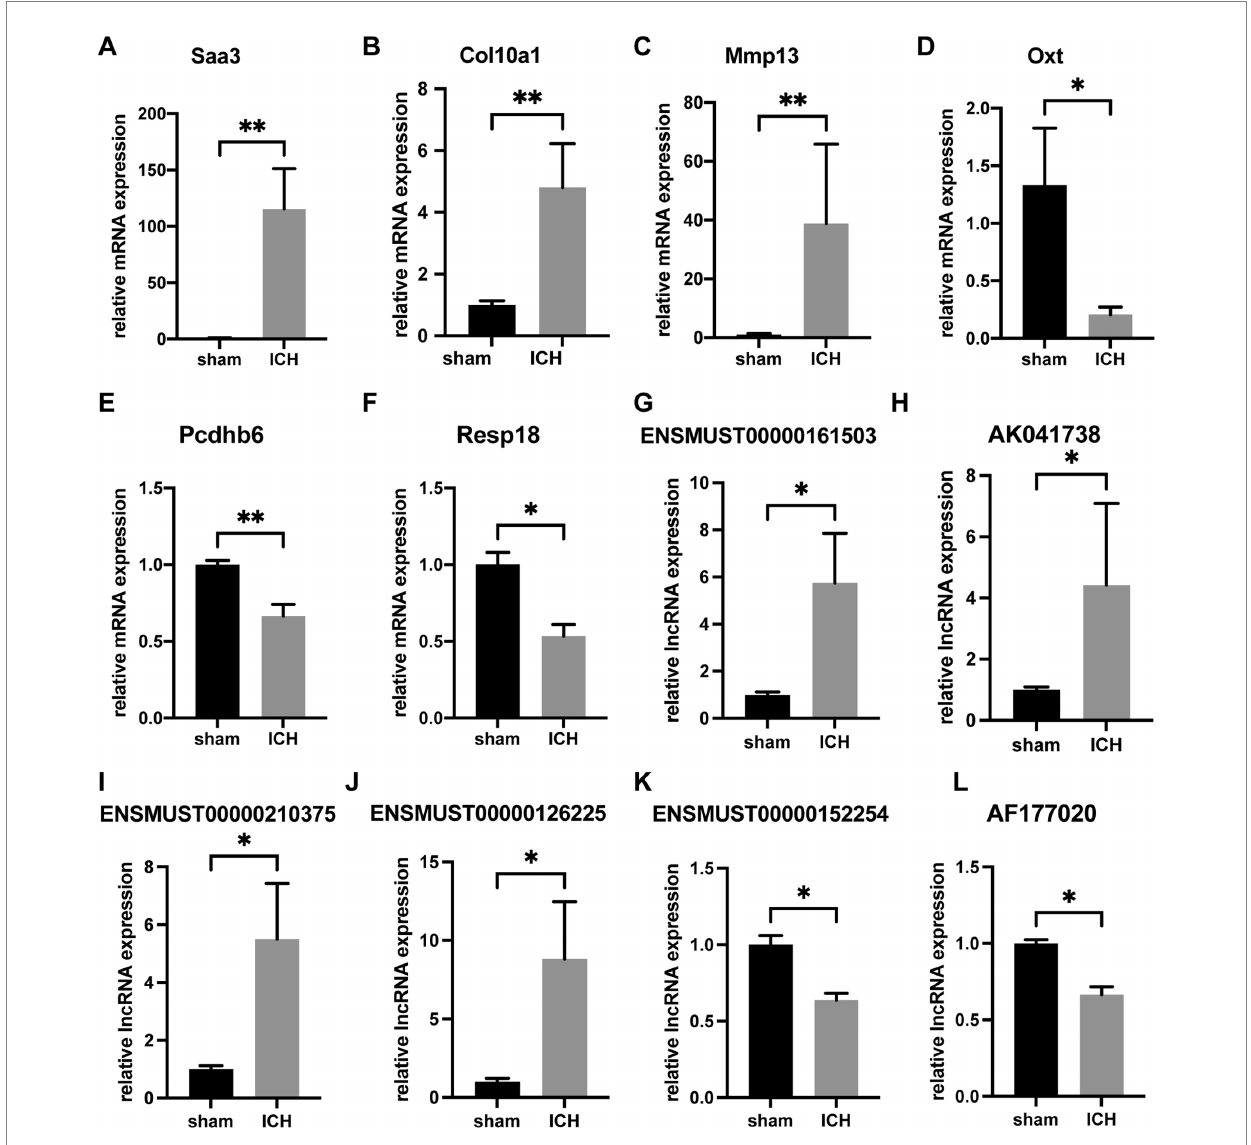
FIGURE 4 RT-qPCR confirmation of differentially expressed mRNAs and lncRNAs. The relative expression of Saa3 (A) , Col10a1 (B) , Mmp13 (C) , ENSMUST00000161503 (G) , AK041738 (H) , ENSMUST00000210375 (I) , and ENSMUST00000126225 (J) was upregulated in ICH group. The relative expression of Oxt (D) , Pcdhb6 (E) , Resp18 (F) , ENSMUST00000152254 (K) , and AF177020 (L) was downregulated in the ICH group. ( n = 4–5 mice in each group) Data are presented as mean ± SEM, * p <0.05, ** p